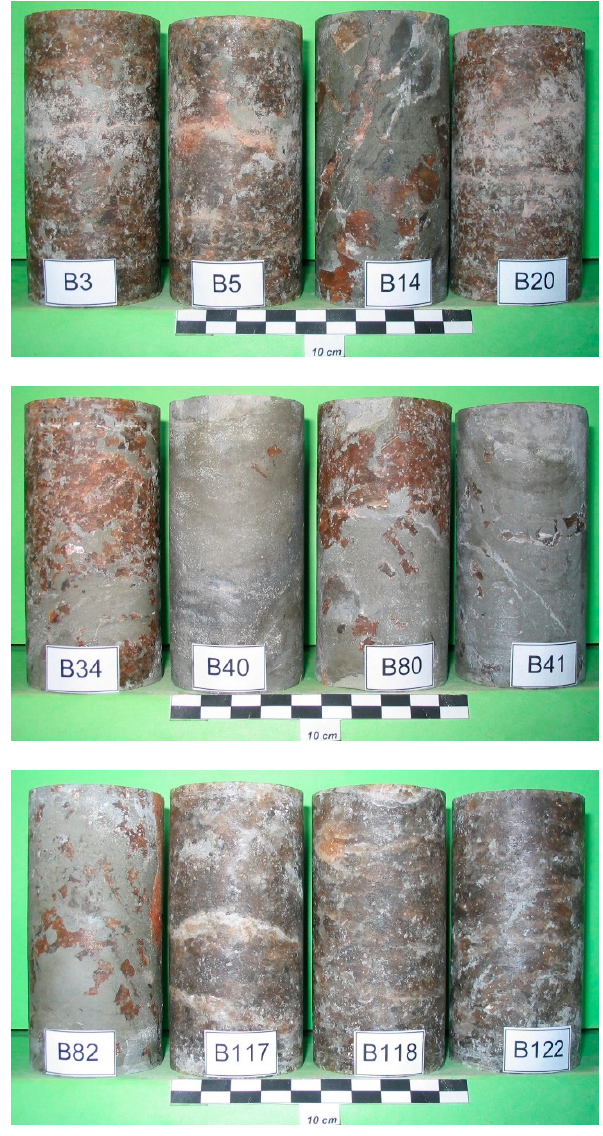
Figure A3. The Brown Zuber unit samples for short-term compression tests at a constant strain rate.